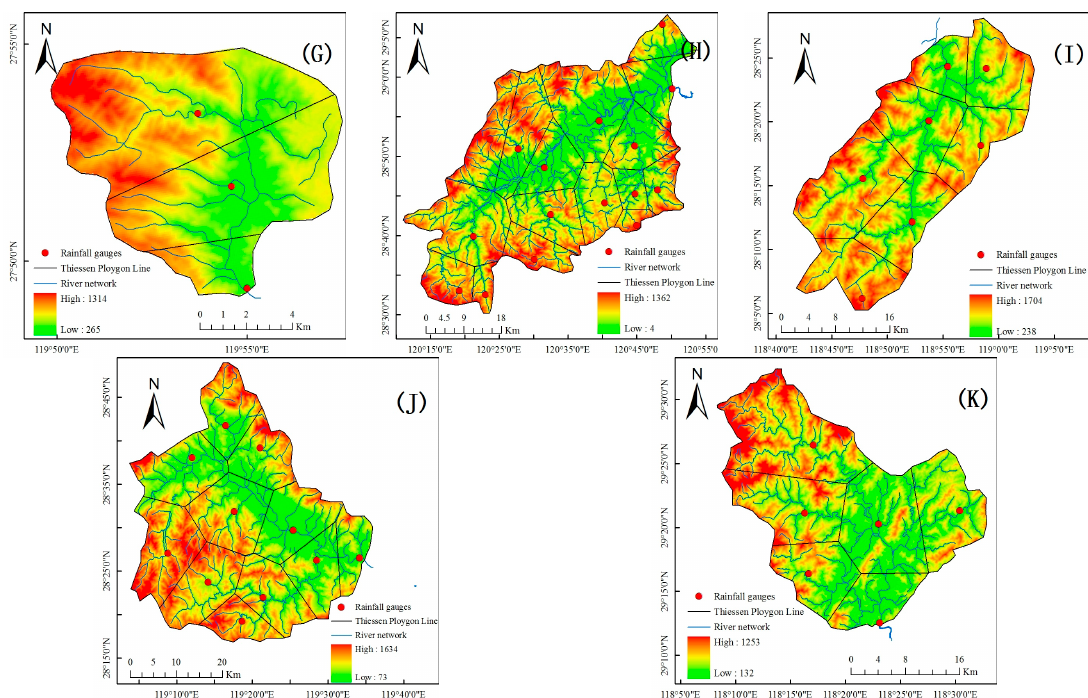
Figure 5. Location maps of the studied basins. ( A ) Baisha; ( B ) Shangshalan; ( C ) Saitang; ( D ) Niutoushan Reservoir; ( E ) Zhongzhou; ( F ) Yanjia Reservoir; ( G ) Gaoerdian Reservoir; ( H ) Bozhiao; ( I ) Zhonggeng; ( J ) Jingjukou; ( K ) Misai.